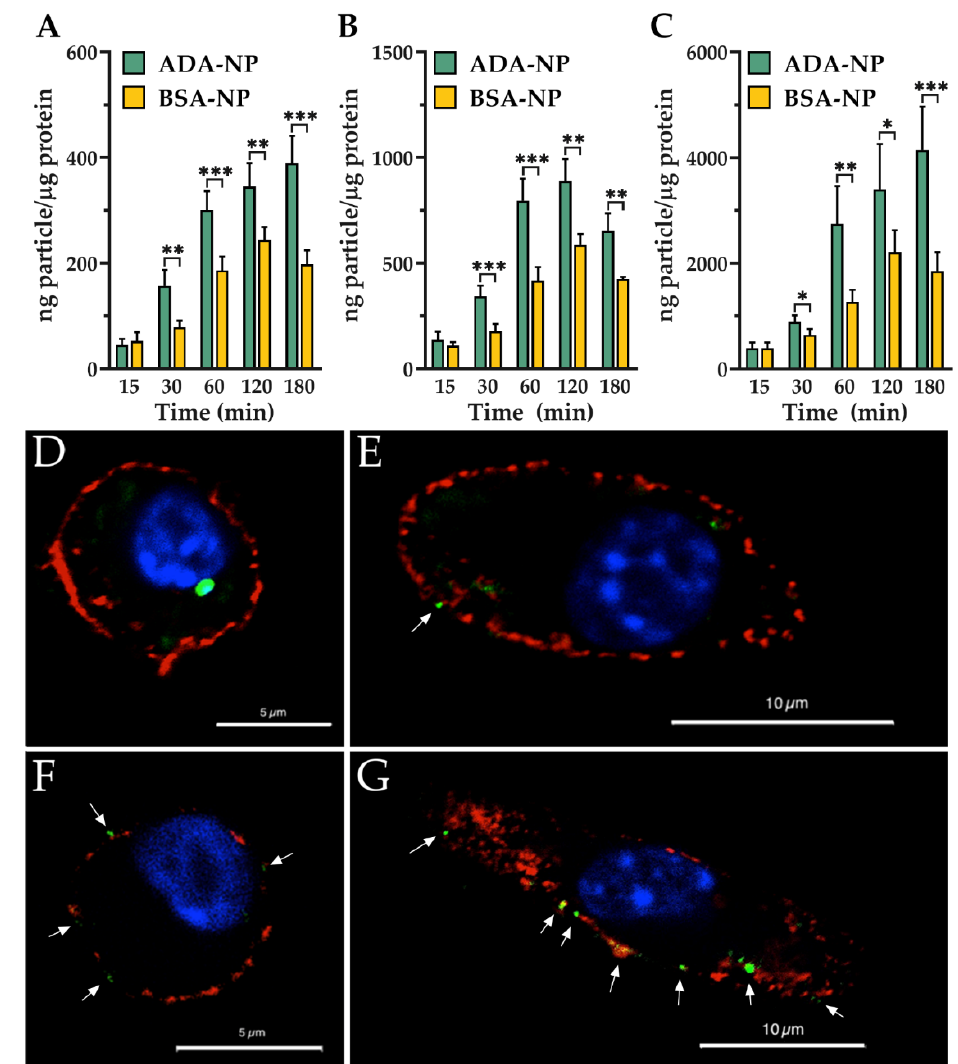
Figure 6. ( A – C ) Combined uptake and binding of adalimumab (ADA) conjugated nanoparticles (ADA-NP) to the inflammatory macrophages in comparison with the control bovine serum albumin (BSA) conjugated nanoparticles (BSA-NP): Cells were treated with 100 µg/mL ( A ), 300 µg/mL ( B ) or 1000 µg/mL ( C ) coumarin 6-loaded ADA-NP or BSA-NP at 37 °C for different time intervals ranging from 15 to 180 min. ADA-NP showed significantly higher cellular association at all time points (starting from 30 min) when compared to the control BSA-NP. Statistical significance was assessed by unpaired T-test (* p < 0.05, ** p < 0.01, *** p < 0.001). ( D – G ) CLSM images comparing the interaction of the ADA-NP ( F , G ) and the control BSA-NP ( D , E ) with inflammatory macrophages: Imaging was carried out on fixed cells following 30 min of incubation with 300 µg/mL nanoparticles (based on the polymeric matrix) at 37 °C. The blue color represents the cell nuclei, the red color the cell membrane and the green color the coumarin 6-loaded nanoparticles. Qualitatively seen, ADA-NP seemed to have significantly higher membrane binding compared to the control BSA-NP.